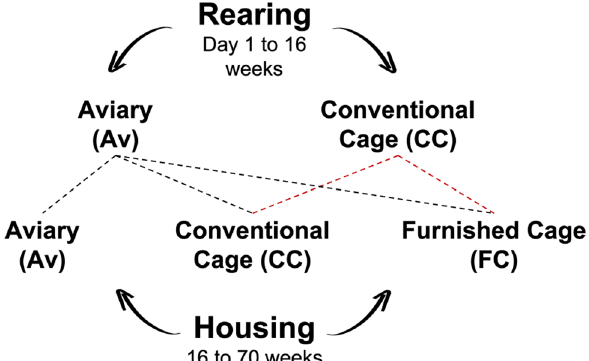
Figure 1. Experiment 1. The combination of maternal rearing and housing experiences formed five treatment groups: Trt1 (Av × Av), Trt2 (CC × CC), Trt3 (Av × CC), Trt4 (CC × FC), Trt5 (Av × FC). This was repeated for two cohorts of hens. Since pullets reared in cages lack experience with navigation in a 3-dimensional space 17 , only pullets reared in aviaries were transferred to aviary